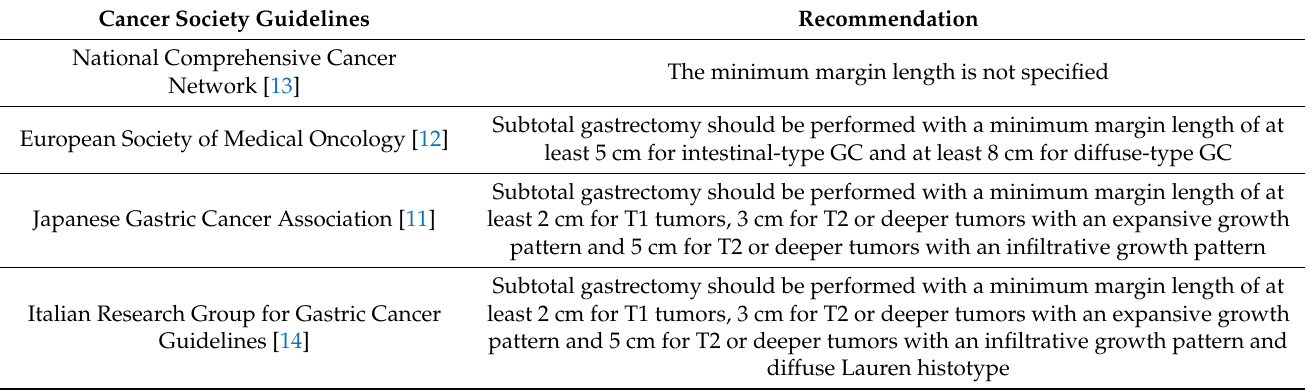
Table 1. Recommendations on the extent of resection for